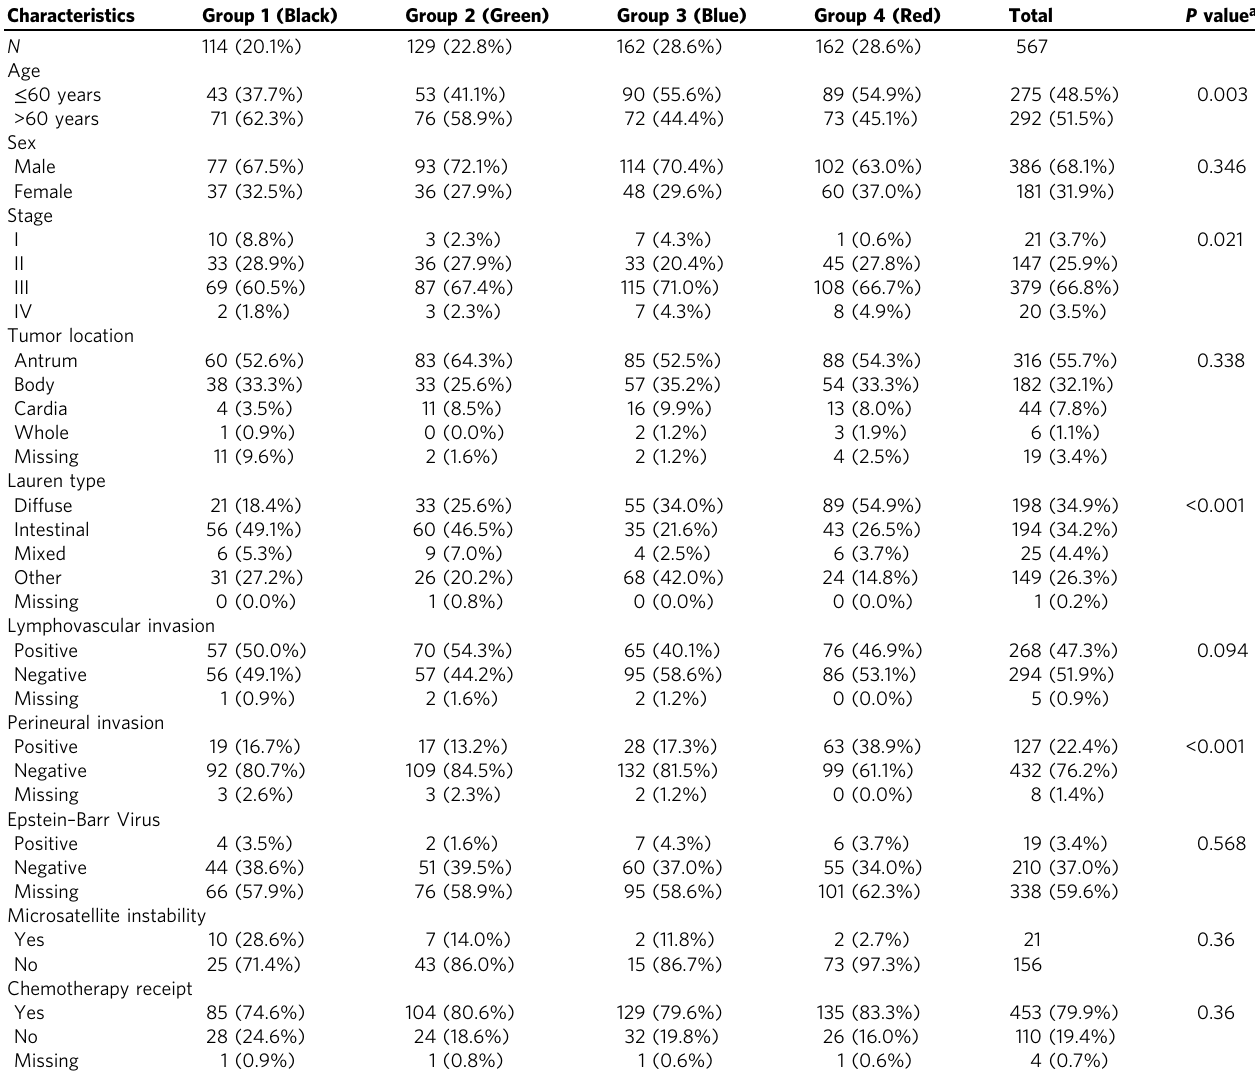
a P values were calculated using the Chi-square